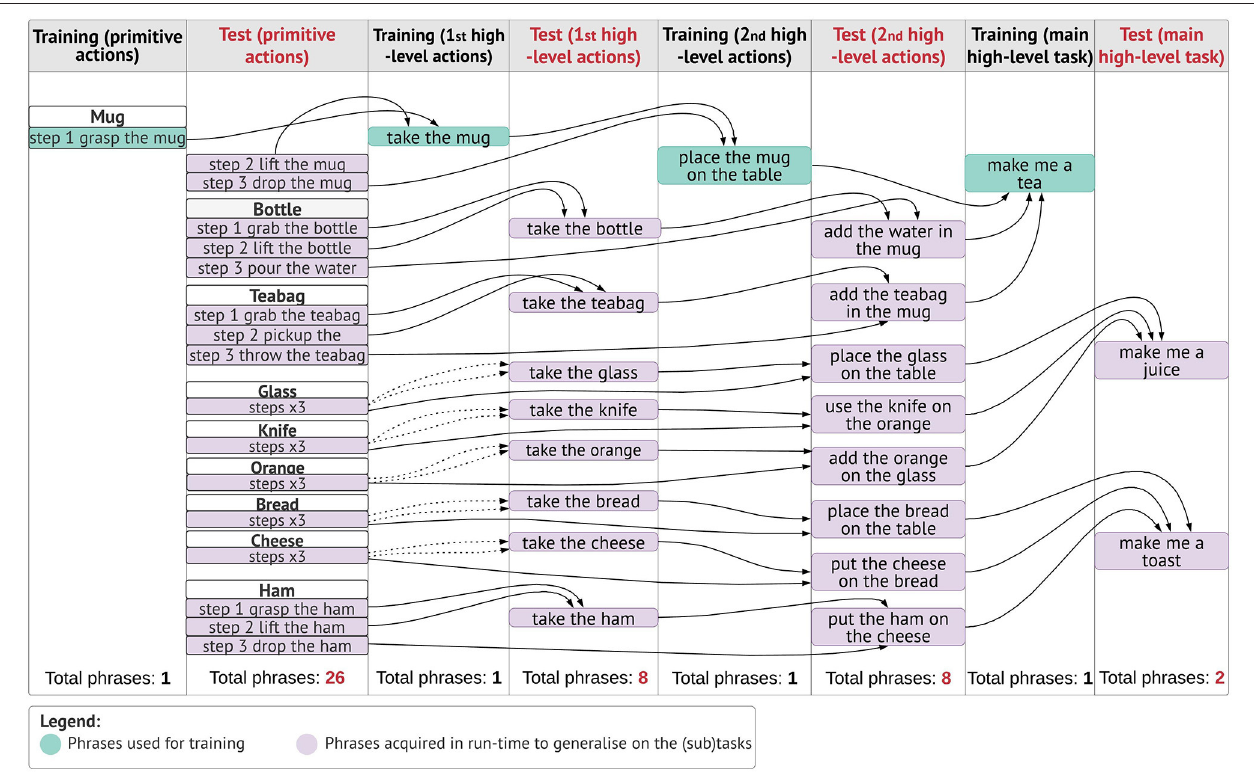
FIGURE 9 | Gradual chain-acquisition of the test set. The model learns new objects and primitive action meanings for those objects. By recalling internal representations of the primitive actions, it converts spoken commands into low-level symbolic sequences. It produces symbolic internal representations for high-level (abstract) by transferring the meanings of primitive actions through the interaction of language with physical exploration. The test set is acquired in sequential steps, by adding similar spoken commands for new objects and involving new actions. As a result, it is verified the ability to learn the semantic meaning of motor primitives and build different internal representations for a given abstract concepts, if the desired outcome and/or the involved tools to reach the outcome have changed (e.g., make tea and make